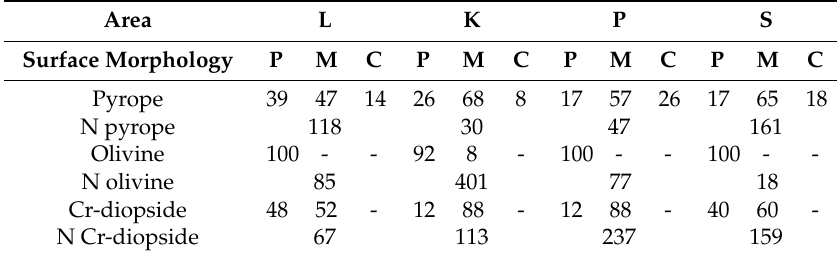
Table 1. The percentage (%) of KIM surface morphologies in the samples from the studied areas. P, primary magmatic; C, chemically abraded; M, mechanically abraded; N, number of grains analyzed. Area L K P S Surface Morphology